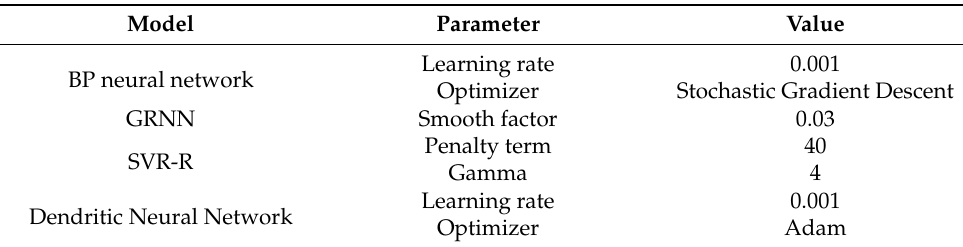
Table 4. The initial parameter values of models.